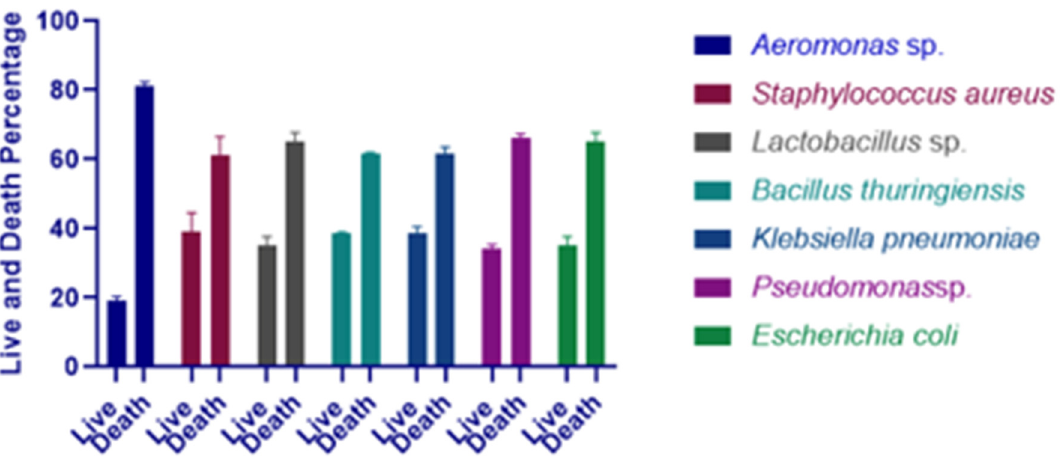
Figure 3. Percentage survival of A. salina larvae after 24 h of infection with Aeromonas sp., Staphylococcus aureus , Lactobacillus sp., Bacillus thuringiensis , Klebsiella pneumoniae , Pseudomonas sp., and Escherichia coli .